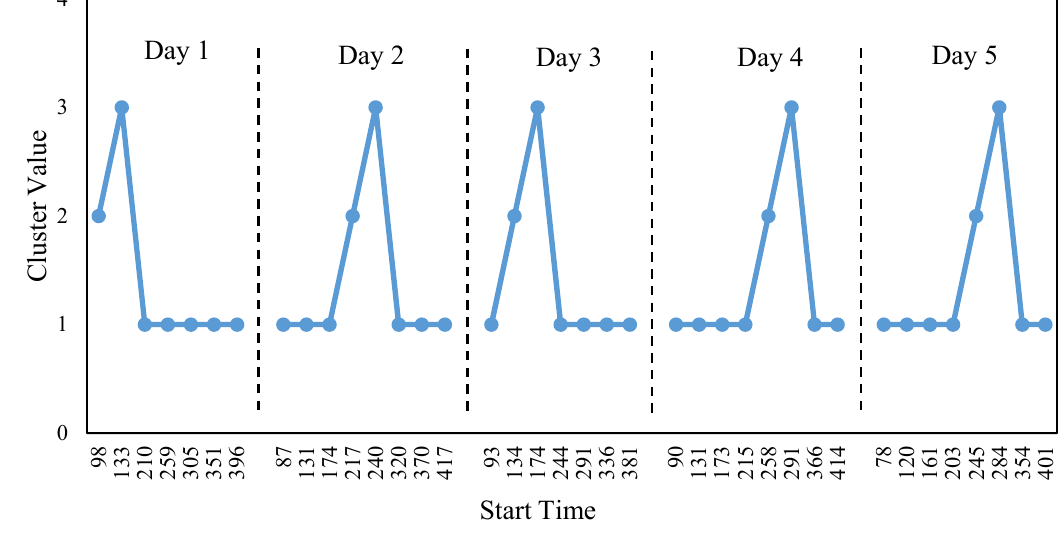
Figure 9. Cluster distribution from 18 January to 22